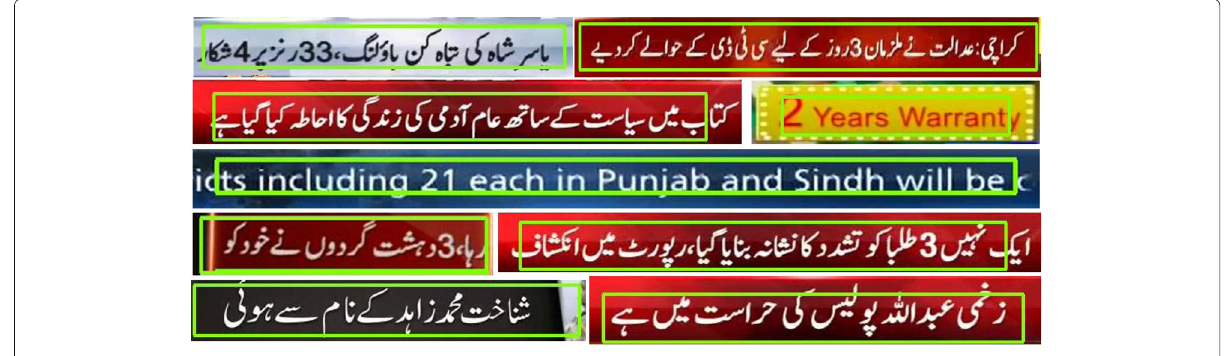
Fig. 14 Imperfect localization of text